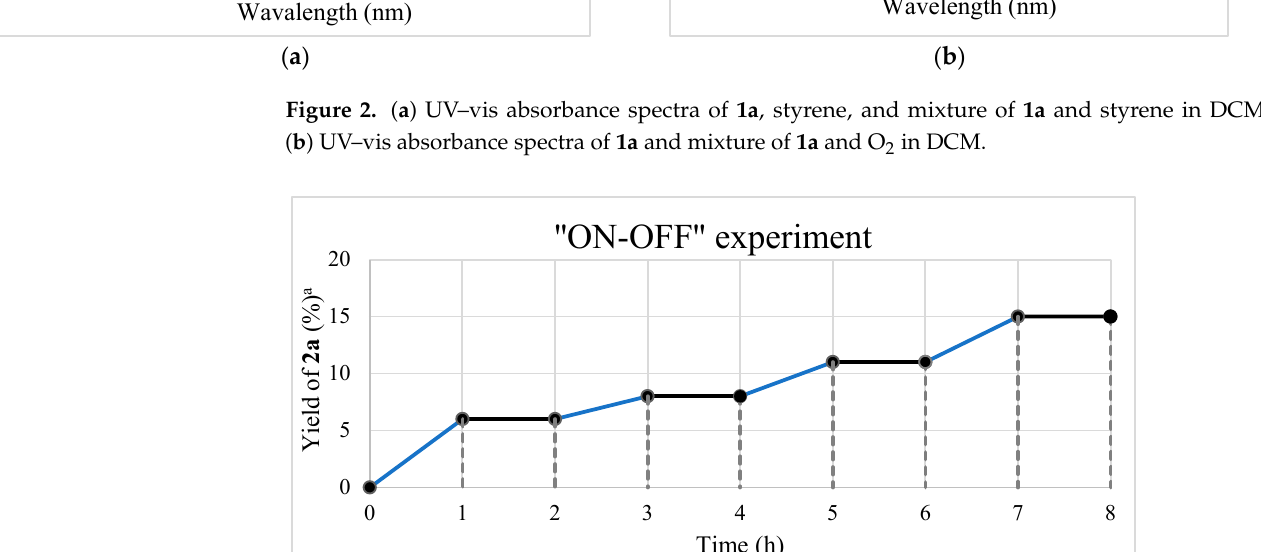
Figure 4. Reaction in the presence of TEMPO.